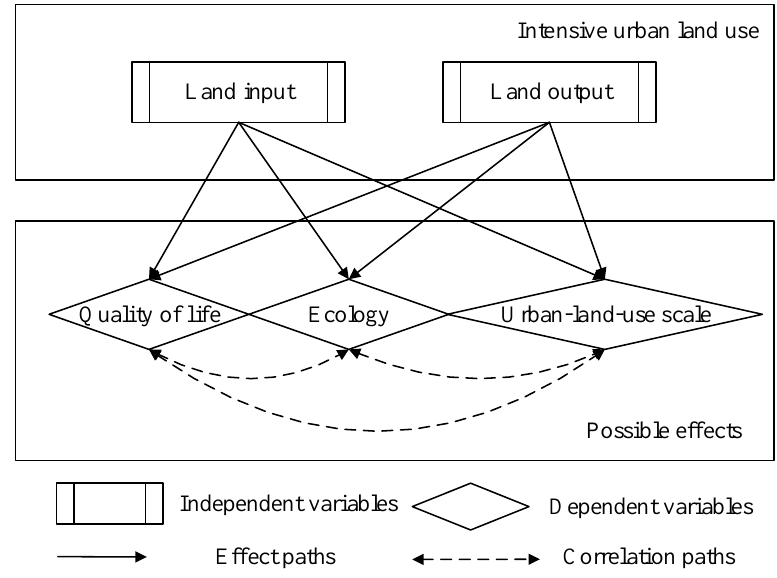
Figure 2. The analysis framework for verifying the effects.